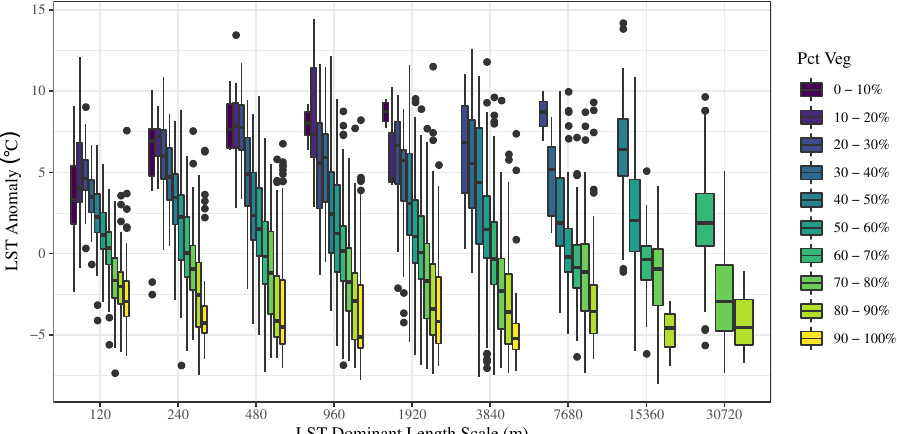
Figure 5. Boxplots showing the interquartile range of LST by the percent of vegetation and the dominant length scales. The bar in each box shows the median and the dots indicate outliers. LST varies only slightly by dominant length scale and decreases as the percent of vegetation increases, regardless of the dominant length scale.